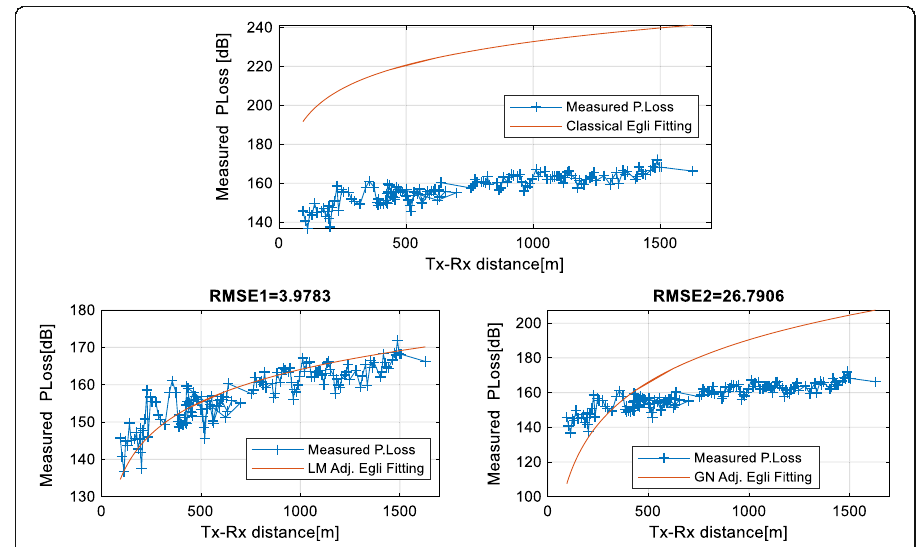
Fig. 6 Measured propagation loss estimation and their error distribution statistics using classical Egli model and adapted Egli model for Cell_3